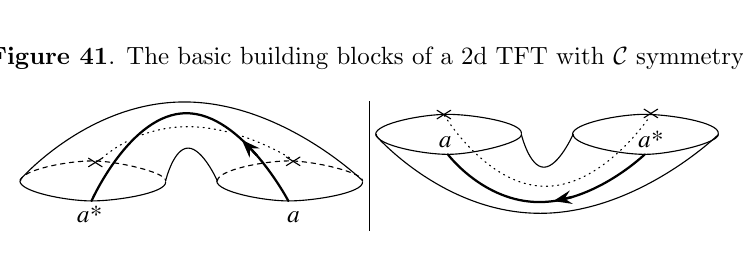
Figure 42 . The pairing of V a and V a (cid:3)